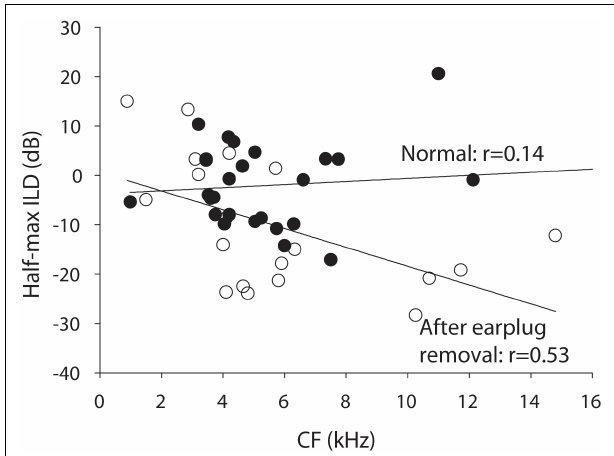
FIGURE 3 | Half-maximal ILD as a function of CF for the normal control animals (black circles) and the experimental animals after 6 weeks of unilateral CHL (open